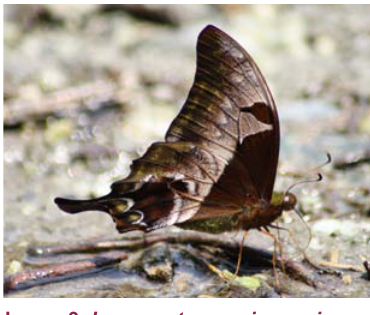
Image 8. Lamproptera curius curius Image 9. Lamproptera curius